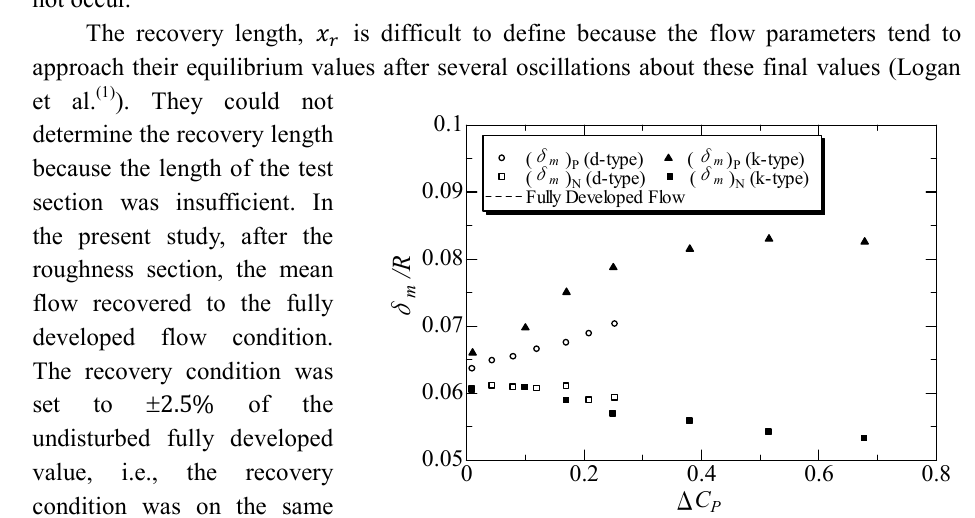
Fig. 10 Peak and minimum values of momentum